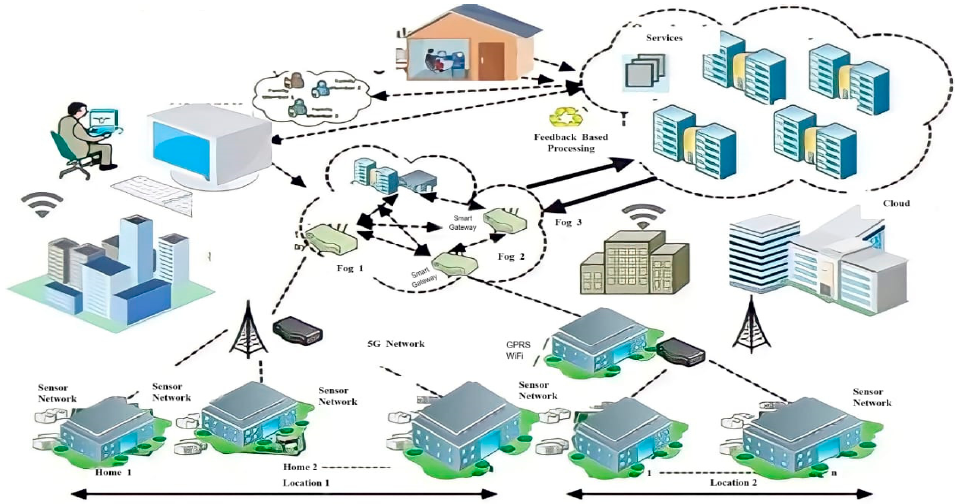
Figure 13. The Proposed secure searchable encryption system.